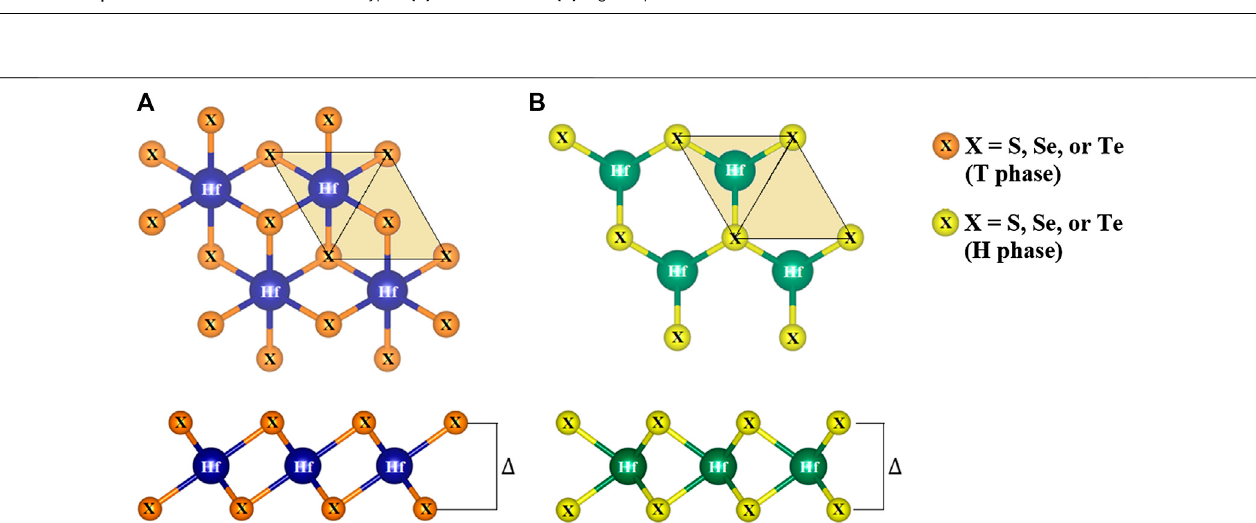
FIGURE 1 | The local coordination of the two types (A) octahedral and (B) trigonal prismatic.